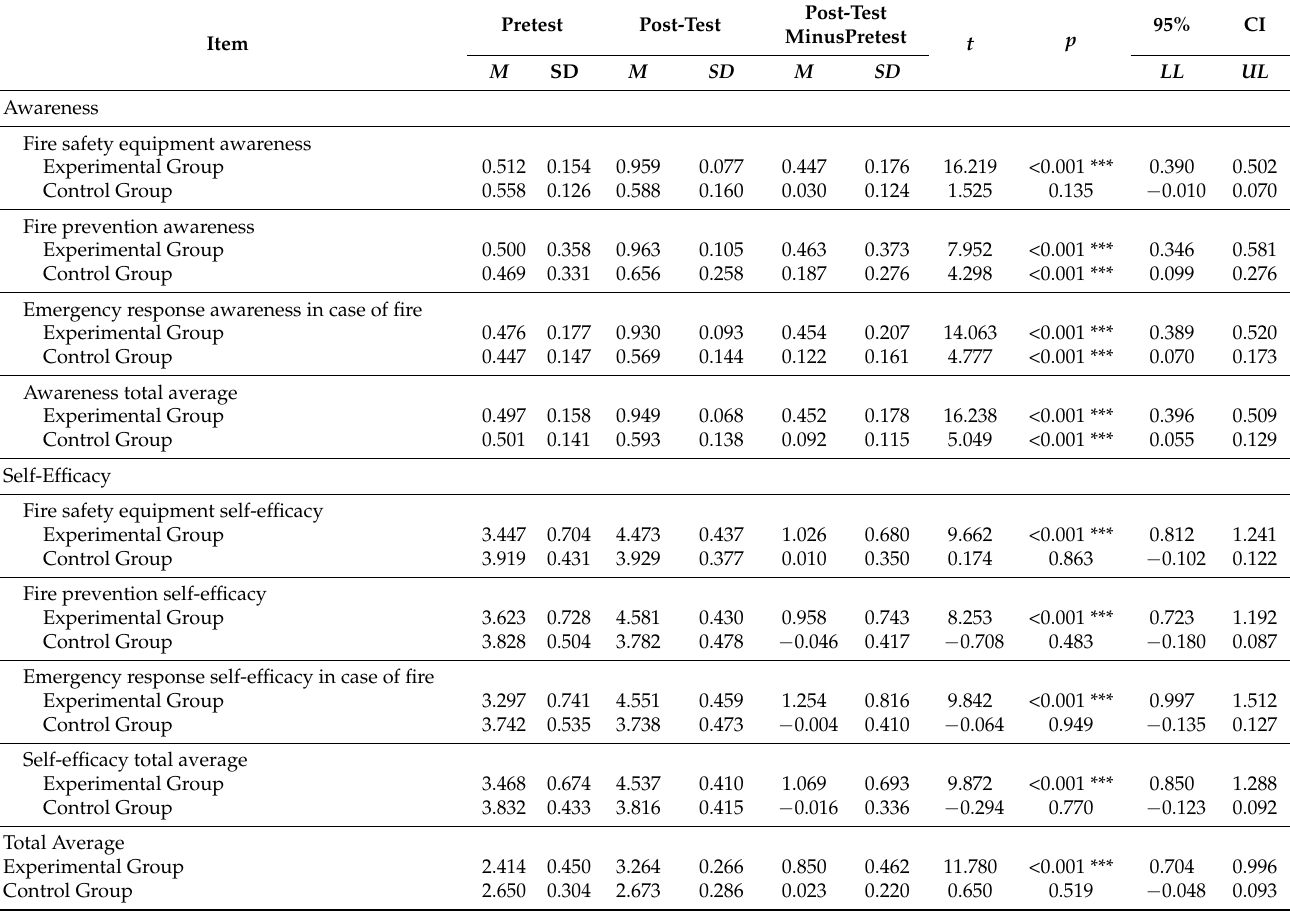
Table 4. Effectiveness comparison of the pretest–post-test of the two groups (N = 81).